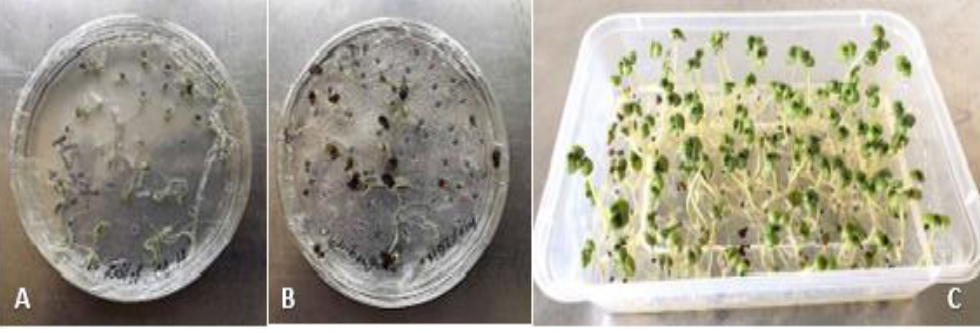
Figure 1. Ocimum basilicum L. seed culture.